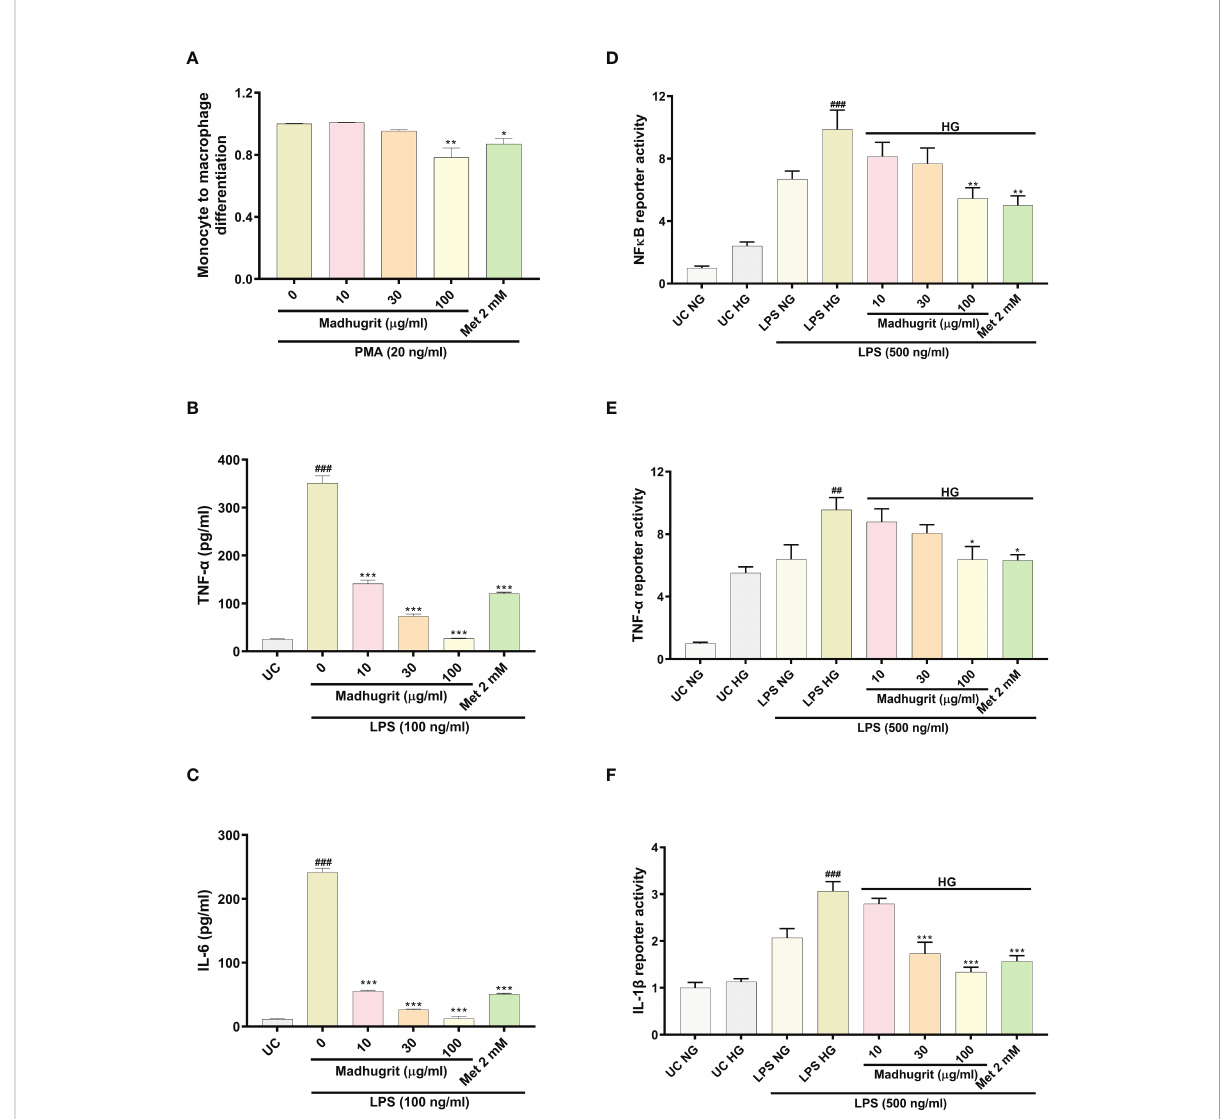
FIGURE 5 Madhugrit reduced monocyte to macrophage differentiation, release and activity of pro-in fl ammatory cytokines and NF- k B response. (A) Madhugrit inhibited the THP1monocyte to macrophage conversion in presence of PMA (20 ng/ml) represented as fold change. (B, C) The levels of released TNF- a and IL-6 (pg/ml) in presence of Madhugrit (0-100 µg/ml) or Metformin (2 mM) after LPS (100 ng/ml) induction. (D-F) Activity of NF- k B, TNF- a and IL-1 b under normal glucose (NG) and high glucose (HG) conditions in presence of Madhugrit (0-100 µg/ml) or Metformin (2 mM) after LPS (500 ng/ml) induction. The statistical signi fi cance of the observed differences in the means compared to the (A) Madhugrit (0 µg/ml) was analyzed through one-way ANOVA followed by Dunnett ’ s multiple comparison test and represented as * (p<0.05) or ** (p<0.01). Statistical signi fi cance between Untreated control (UC) and Madhugrit (0 µg/ml) group (B, C) is represented as ### (p<0.001) and between UC HG and LPS HG group (D-F) as ## (p<0.01) or ### (p<0.001). Comparison of the treatments with Madhugrit (0 µg/ml) or LPS HG group was represented as *, ** or *** depending on whether the calculated p value was <0.05, <0.01 or